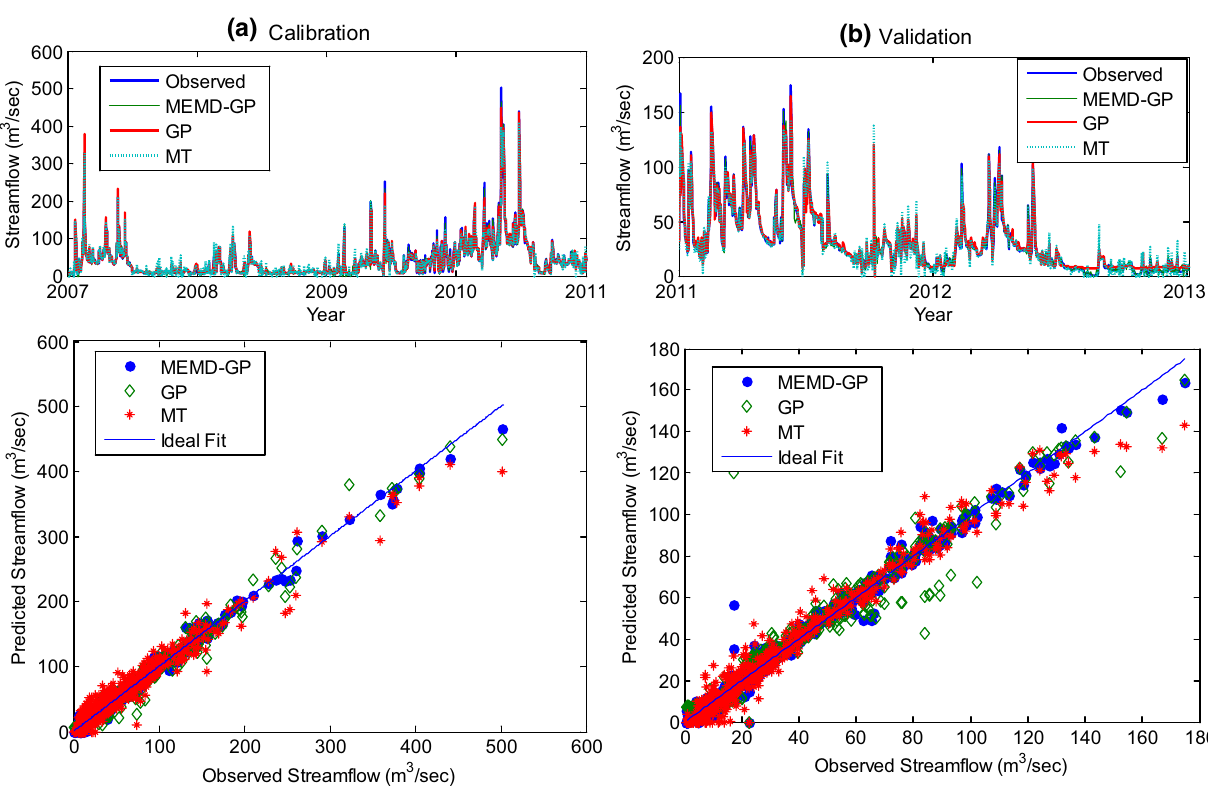
Fig. 4 Daily discharge predictions for Pattazhy station by different methods. Upper panels show time series plots; lower panels show scatter plots Table 3 Results of performance evaluation of streamflow prediction models with different input model